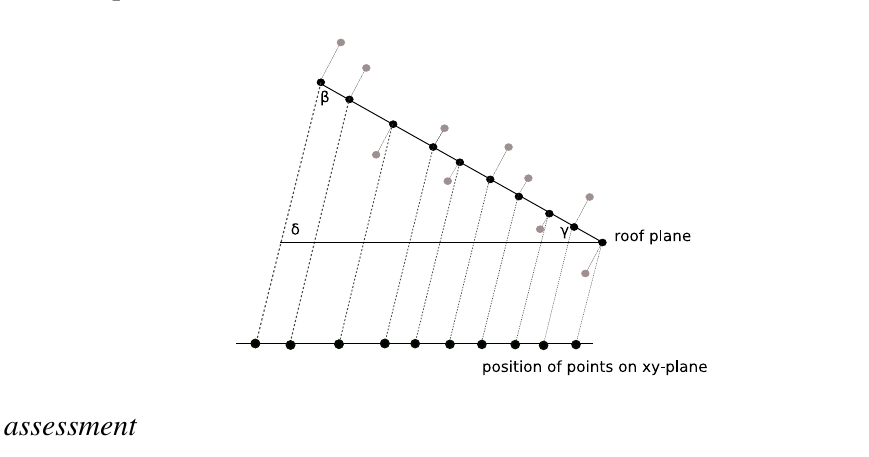
Figure 2. The projection of each point lying on a roof plane on the xy-plane. The dashed line is determined by the inclination angle γ of each roof segment. For simplicity the figure is shown in 2D profile.